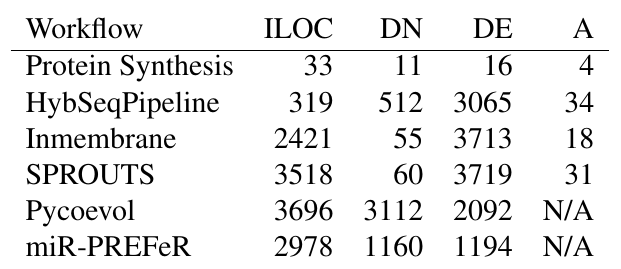
Table 2: WISE results on test workflows. ILOC is the number of lines of code of the instrumented workflow. DN and DE are the number of nodes and edges in the concrete dataflow dependency graph, respectively. A is the number of nodes obtained in the abstract dataflow graph and